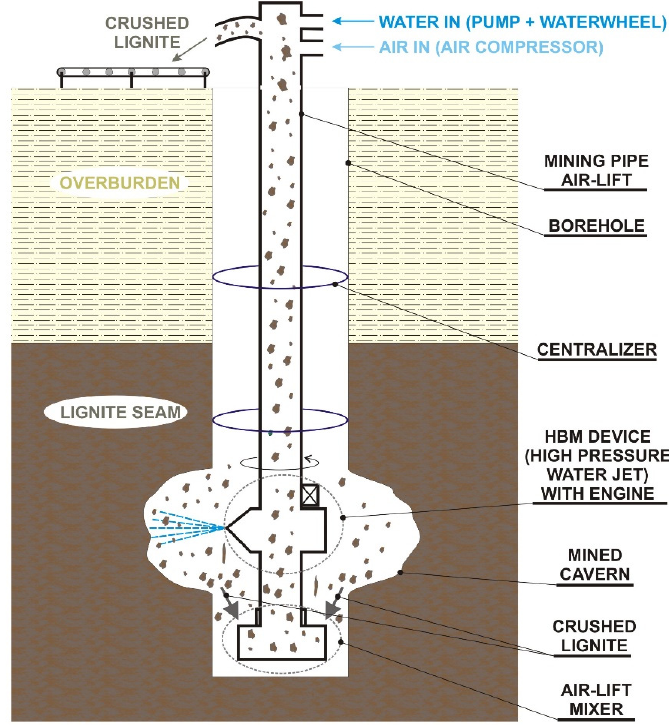
Figure 1. The concept of hydro borehole mining.